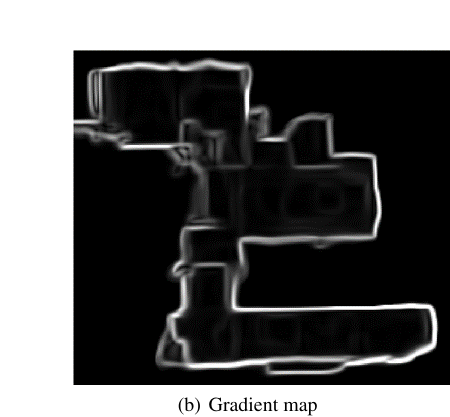
Figure 1: Local height smoothing example in 1 grid. (a)(b): before smoothing; (c)(d): after smoothing. L G = 3 m . Height is color coded.